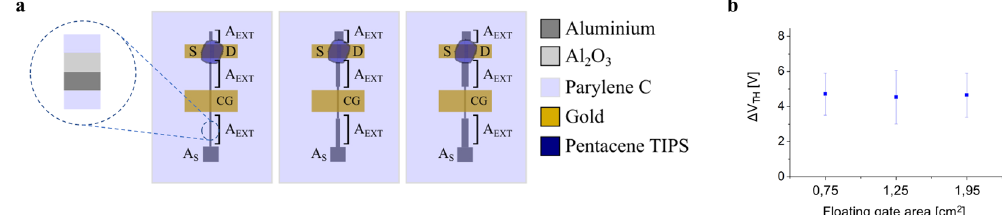
Figure 1. OCMFET layouts and V TH dependence on the floating gate area. ( a ) Schematic representation of the three different OCMFET structures that have been tested to assess the dependence of the V TH from the external areas (5 devices for each external area dimension). The transistor and the control gate area are the same in all three devices. ( b ) Shift of the threshold voltage ( Δ V TH ) after the connection of the floating gate with the PVDF. No correlation was observed between Δ V TH and the floating gate